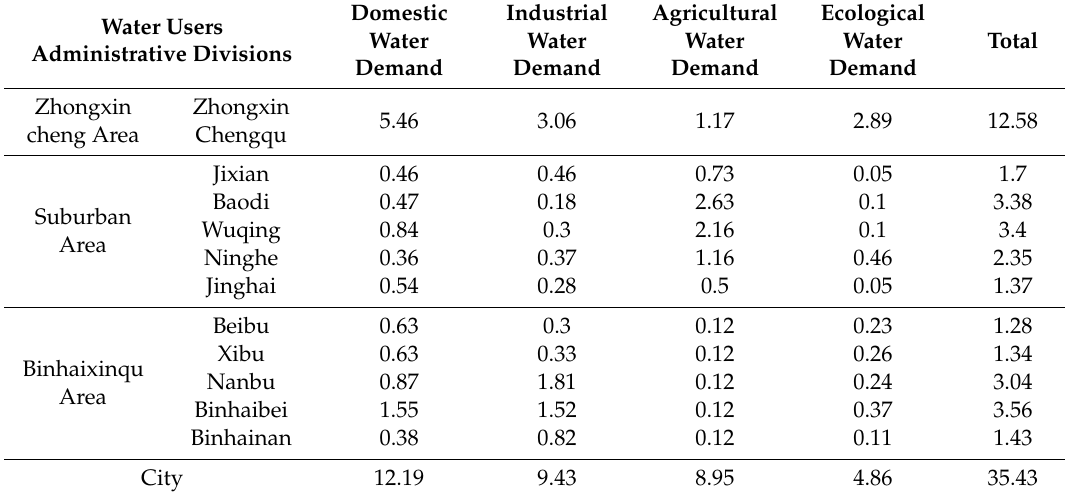
Table 1. Water demand forecasting for Tianjin in 2030 (units = 10 8 m³).